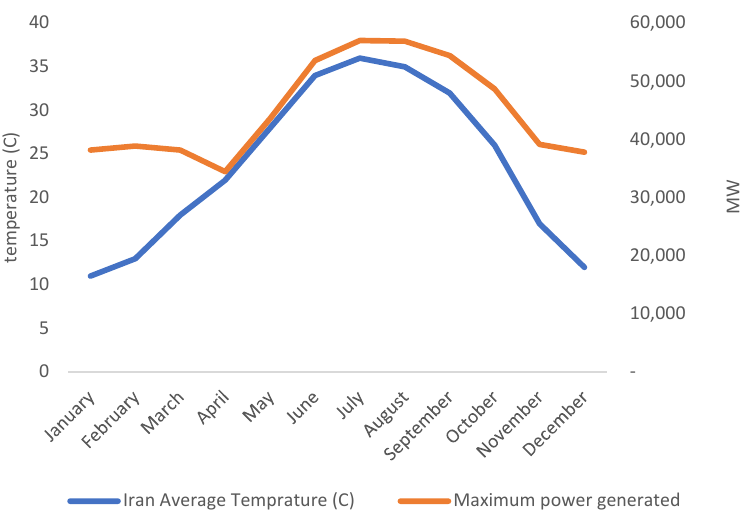
Figure 7. Electricity load and average temperature for Iran.